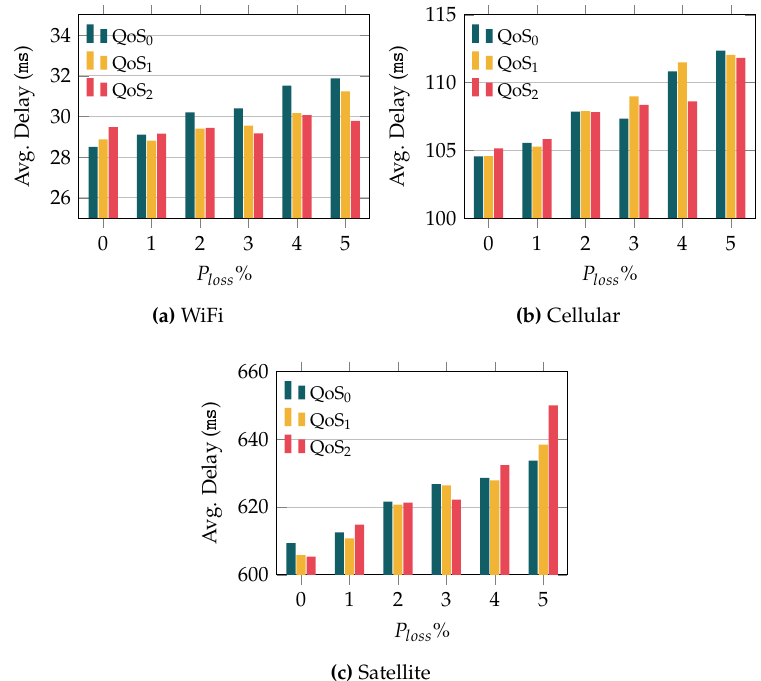
Figure 8. Delay experienced with QUIC for the various QoS configurations.